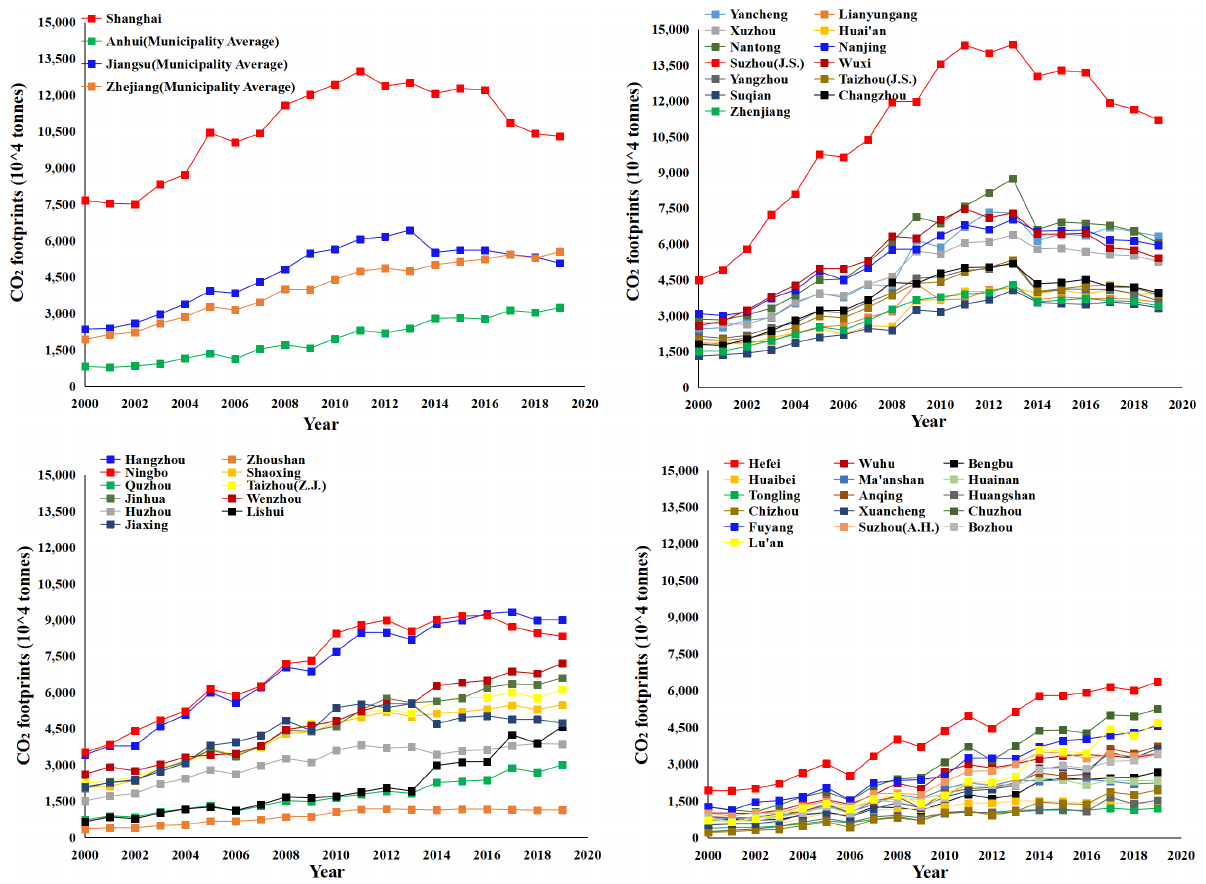
Figure 4.Figure 4. Spatio-temporal evolution of the CO 2 footprints in the YRD from 2000 to